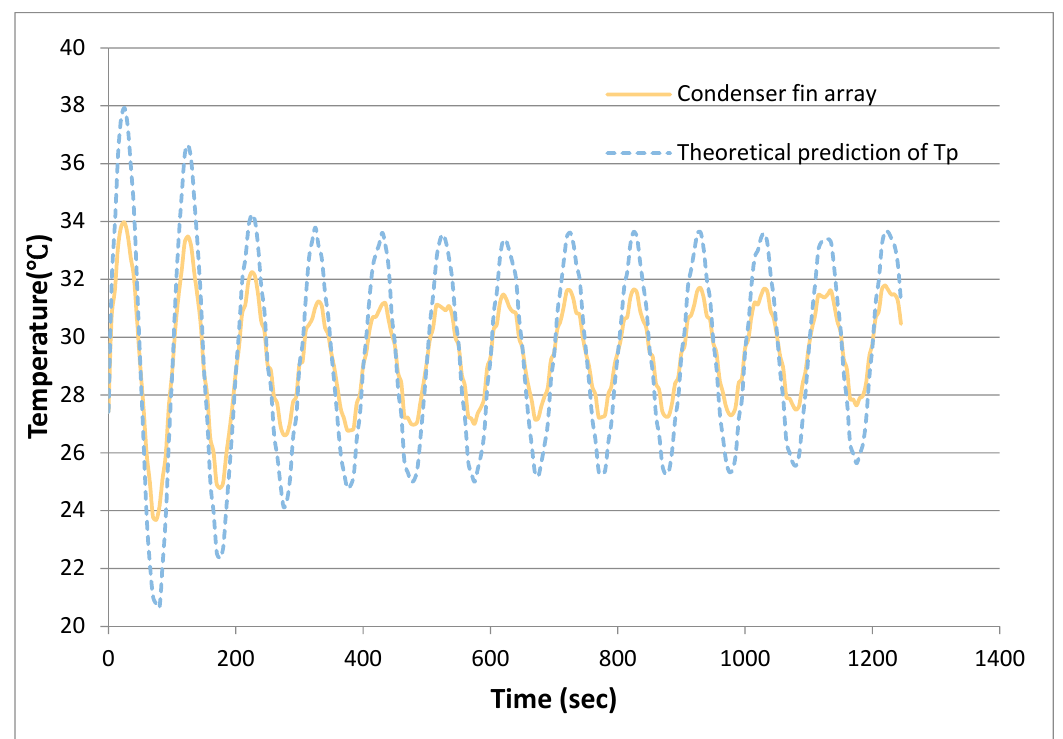
Figure 9. Displacer chamber gas temperature g